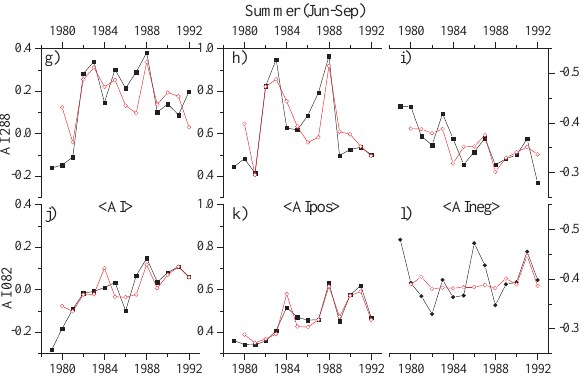
Figure 3. Multiple regression models (MRM) of the annual (a – f) and summer (June–September; g – l ) AI series: (a, d, g, j) (cid:104) AI (cid:105) series; (b, e, h, k) (cid:104) AIpos (cid:105) series; (c, f, i, l) (cid:104) AIneg (cid:105) series (please note the inverted y axis). MRMs are calculated for two locations: ID